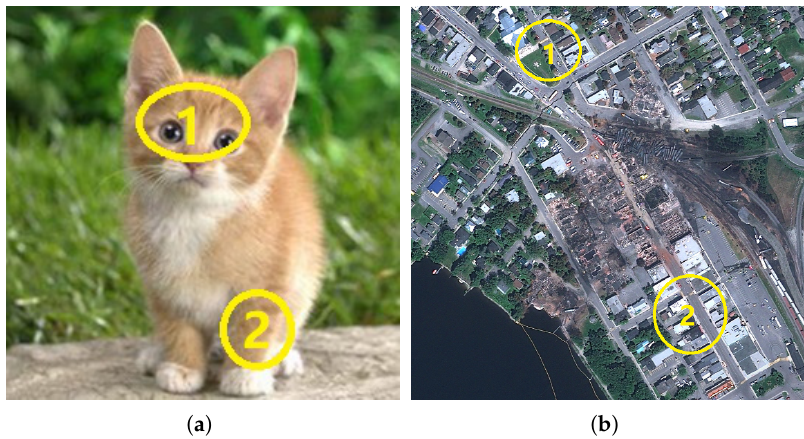
Figure 2. ( a ) Ordinary optical image; ( b ) Remote sensing